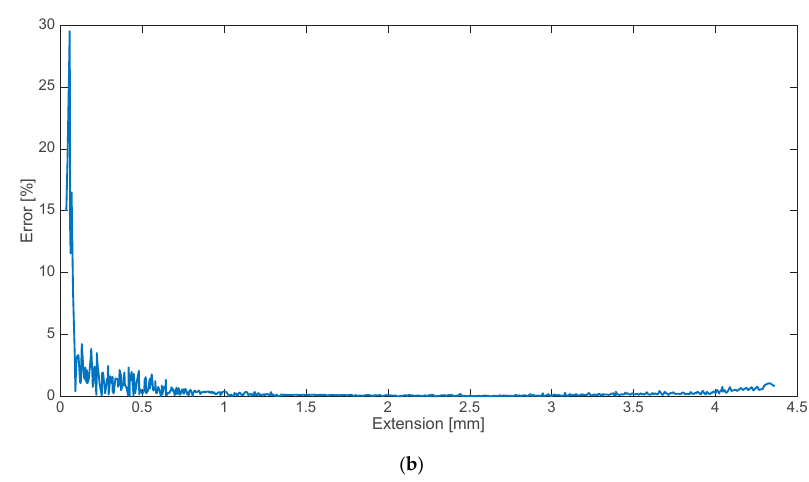
Figure 4. Strength characteristics ( a ) and error values ( b ) for 10% blood admixture.